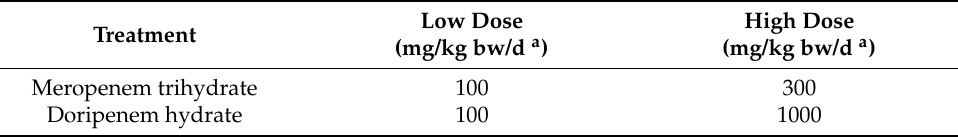
Table 1. Compounds used, dose levels, and form of preparation. All compounds were administered orally using